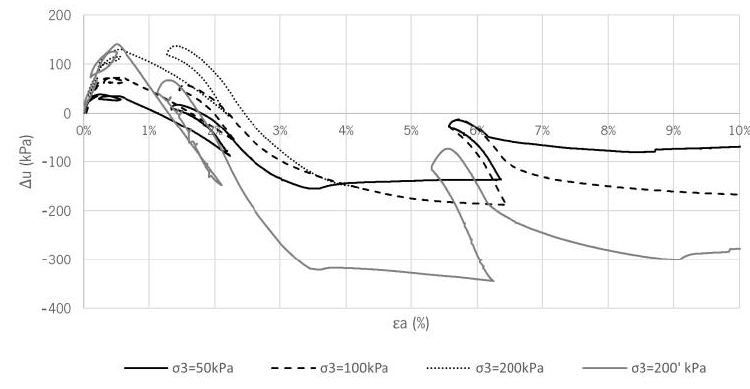
Figure 20. Evolution of pore pressure with axial strain (stabilized specimens).